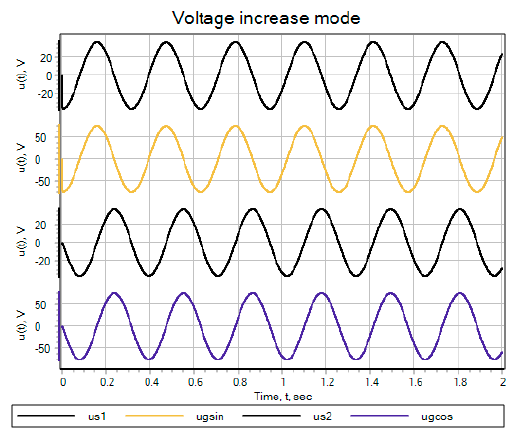
Figure 17. Voltage applied to the load when the stator windings are connected in series.